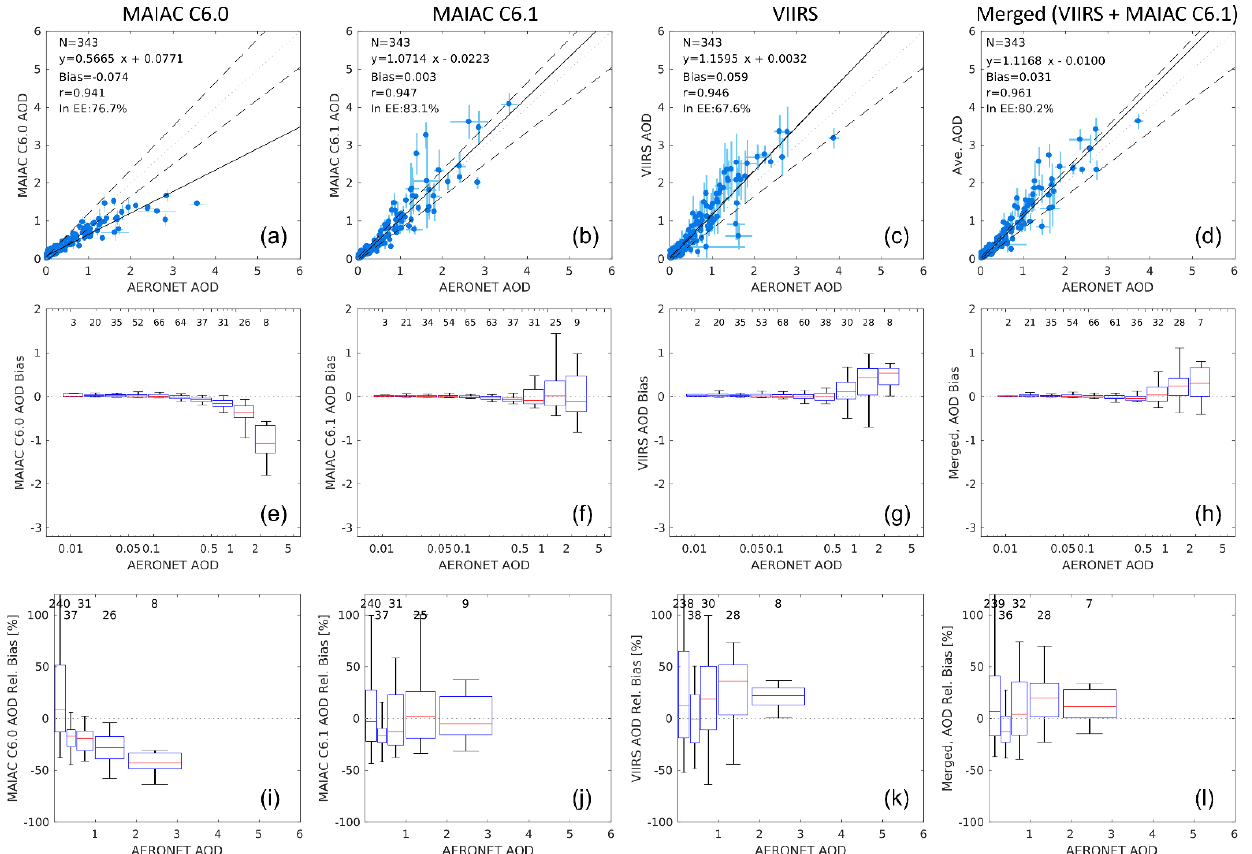
Figure 3. Similar as panels ( a – l ) in Figure 2, but for best-quality satellite AOD and AERONET AOD matchups when all the three products are available simultaneously. The first three columns are re- sults for MAIAC C6.0, MAIAC C6.1, and VIIRS. The last column corresponds to validation of merged AOD by averaging the matchups for VIIRS and MAIAC C6.1.